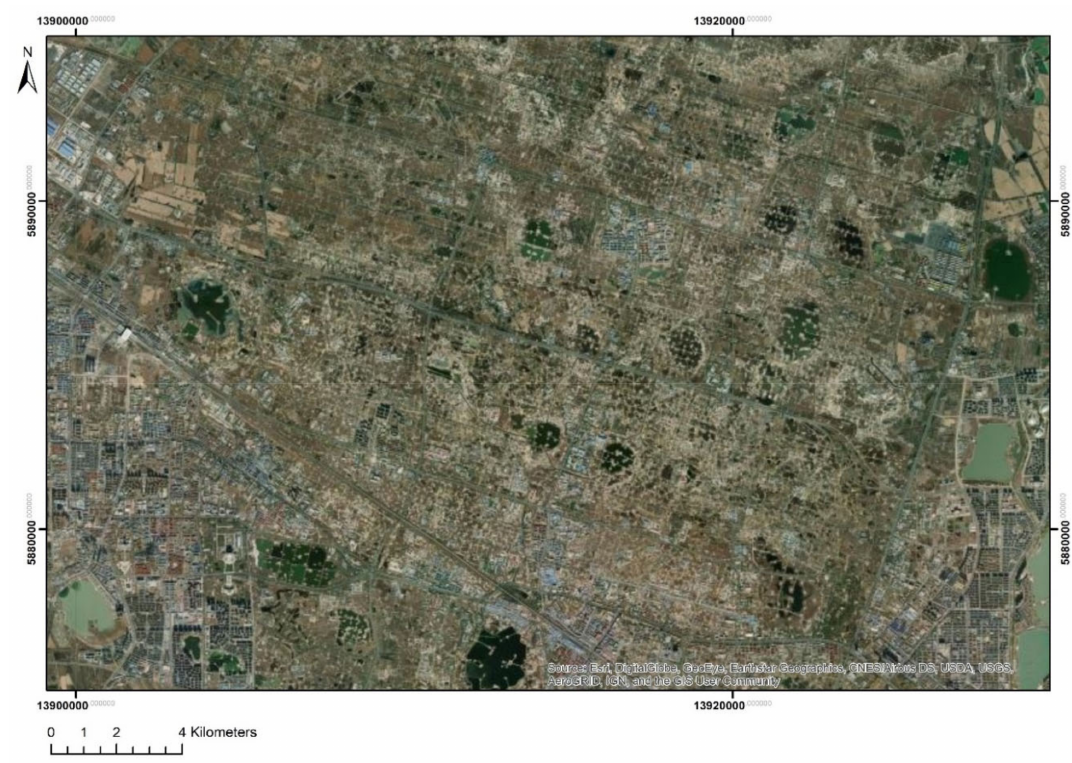
Figure 4. The central area of the mapping area of Daqing where the oil field and the city meet. Picture from the World Imagery of ArcMap.